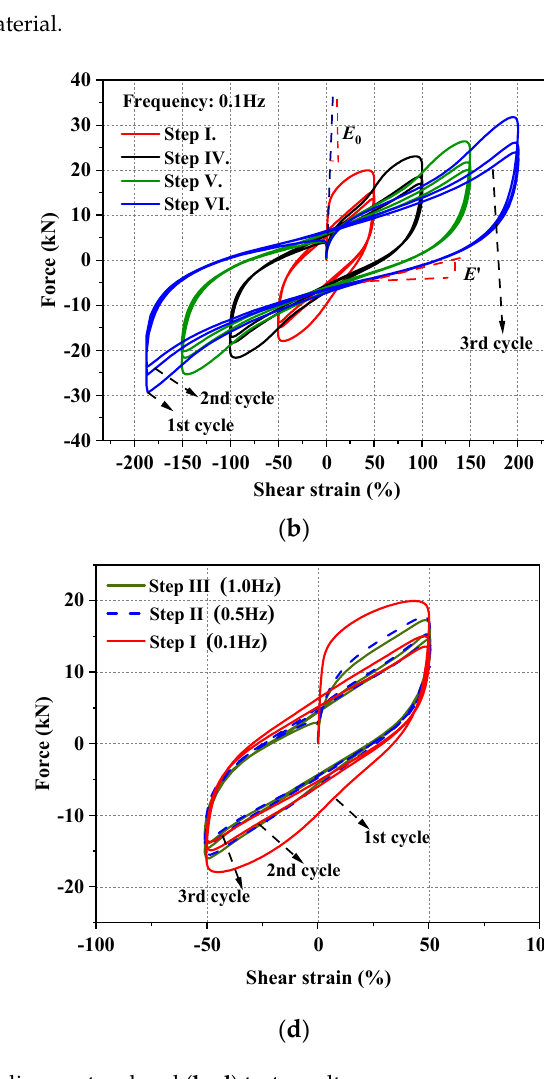
Figure 8. Tests of rubber layer: ( a ) loading protocol and ( b – d ) test results.